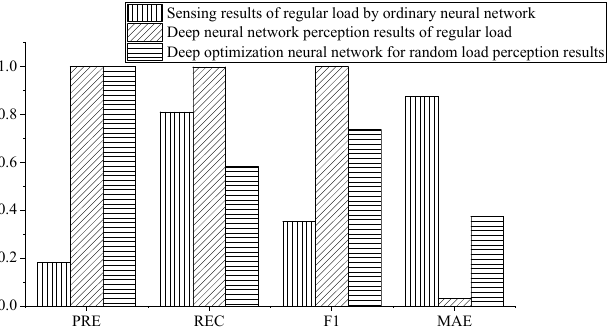
Figure 16. Comparison of load perception results of electric vehicle charging stations.